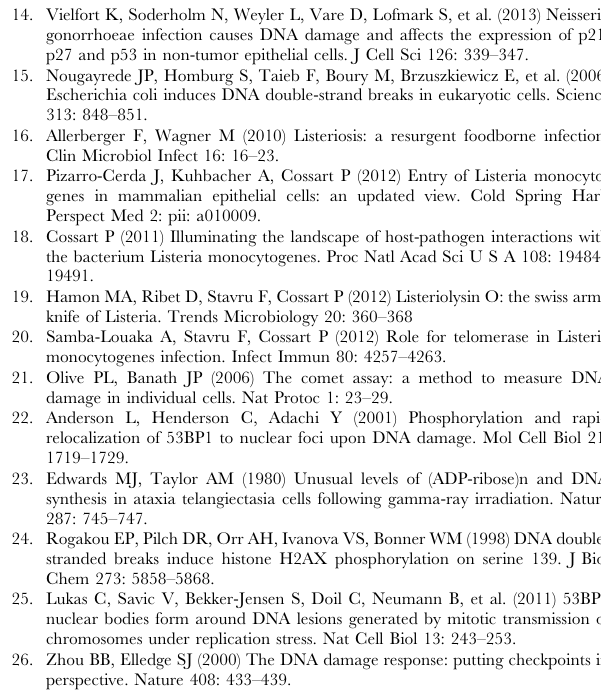
Figure S1 Levels of poly-ADP ribosylated proteins and c H2AX as a function of multiplicity of infection and bacterial strains. (A) HeLa cells are infected with L. monocytogenes using the indicated multiplicity of infection (MOI) and harvested for immunobloting after 24 h of infection. (B) HeLa cells are infected with the indicated bacterial strains and harvested for immunobloting after 24 h of infection. (PDF) Figure S2 Effect of infection with L. monocytogenes on 53BP1 foci and the host cell cycle. (A) HeLa cells are infected with L. monocytogenes for 24 h. Immunofluorescence using an antibody specific to 53BP1 is shown. Arrows show cells with more than 3 foci of 53BP1 which are quantified in figure 1. Scale bar is 30 m m, insert is 2.5 times larger than box in original image. (B) Cell cycle quantification of HeLa cells infected ( + ) or not ( 2 ) with L. monocytogenes for the indicated times. In the table the numbers used to draw the graph are shown + / 2 SEM. (* p , 0.05). (PDF) Figure S3 L. monocytogenes mediates its effect on the DDR from the outside of the cell. (A) Quantification of comet assays performed on HeLa cells infected with the indicated strain for 24 h. Cytochalasin D treatment was performed for 15 minutes prior to infection. Each bar in the histogram is an average of at least 30 nuclei from at least 3 independent experiments. Quantifications show the mean + / 2 SEM (** indicates p , 0.01). (B) Immunoflu- orescence of c H2AX. Each box is 100 m m in length. (C) Immunoblot image representative of 3 independent experiments. (JPG)